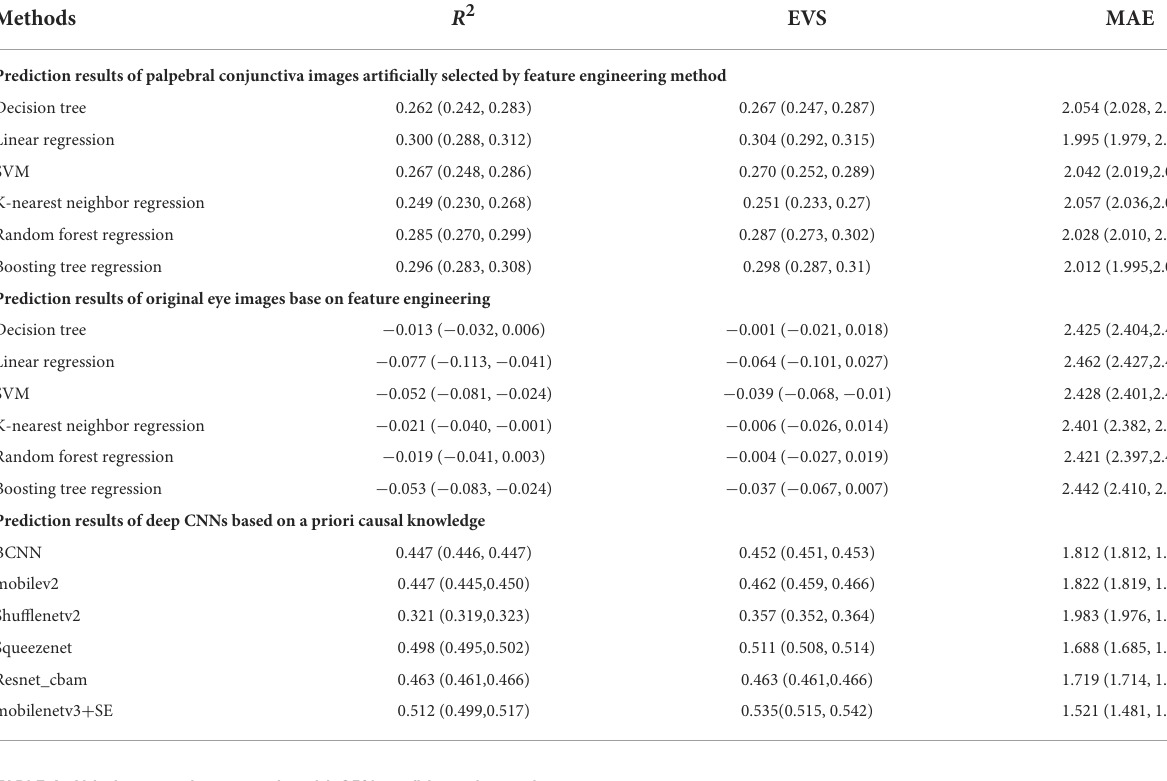
TABLE 3 Model experimental results with 95% confidence intervals.